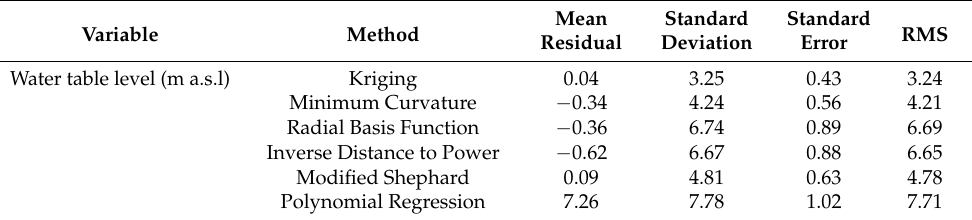
Mean Standard Standard Residual Deviation Error RMS Mean Standard Standard RMS Residual Deviation Error